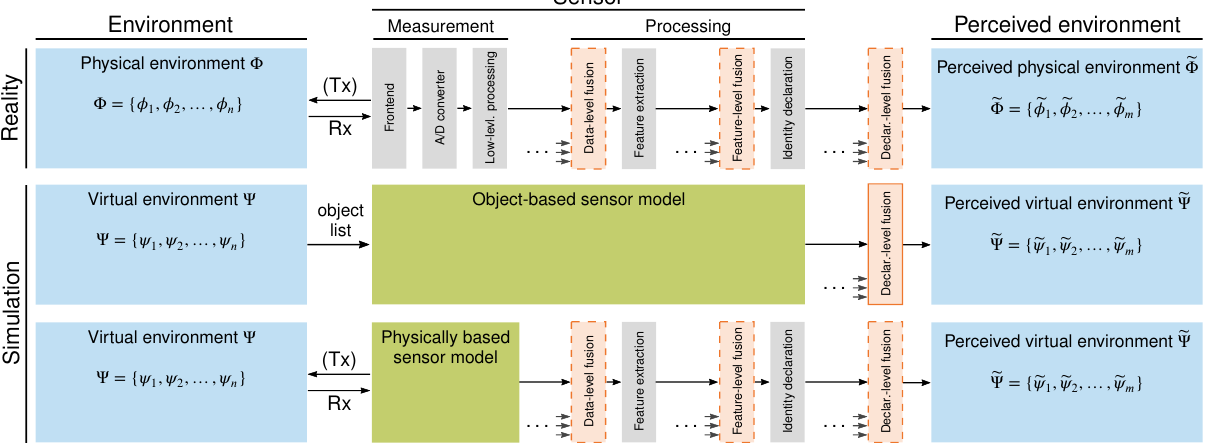
nal. Active environment sensors include RADAR, LiDAR and ultrasonic sensors. In contrast, passive sensors rely on exter- nally emitted energy. For example, image sensors in cameras detect the amount of light received and process this information into pixel color values. The output of the measurement unit is referred to as sensor raw data. The subsequent processing unit uses the raw data to extract features. Then, objects are identified with bounding boxes, velocity vectors, classification probabili-